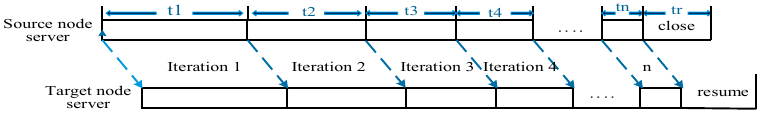
Figure 5. Copy dirty data repeatedly adopting pre-copy mode.